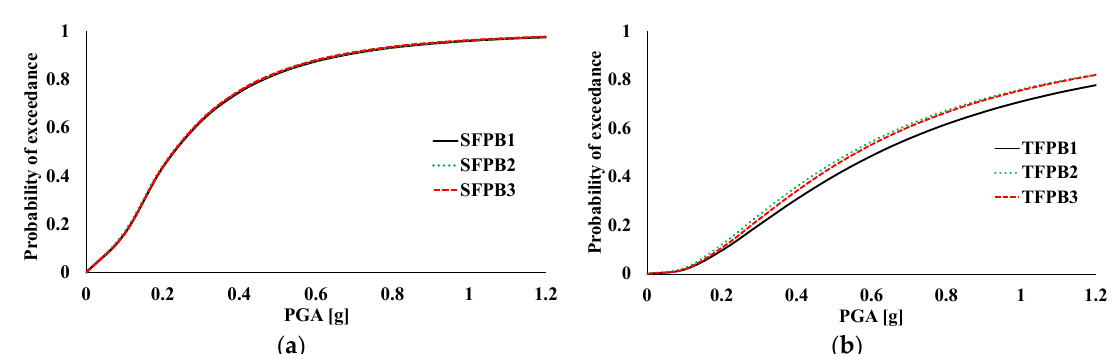
Figure 9. Fragility curves for the storage tank equipped with: ( a ) SFPB and ( b ) TFPB schemes.